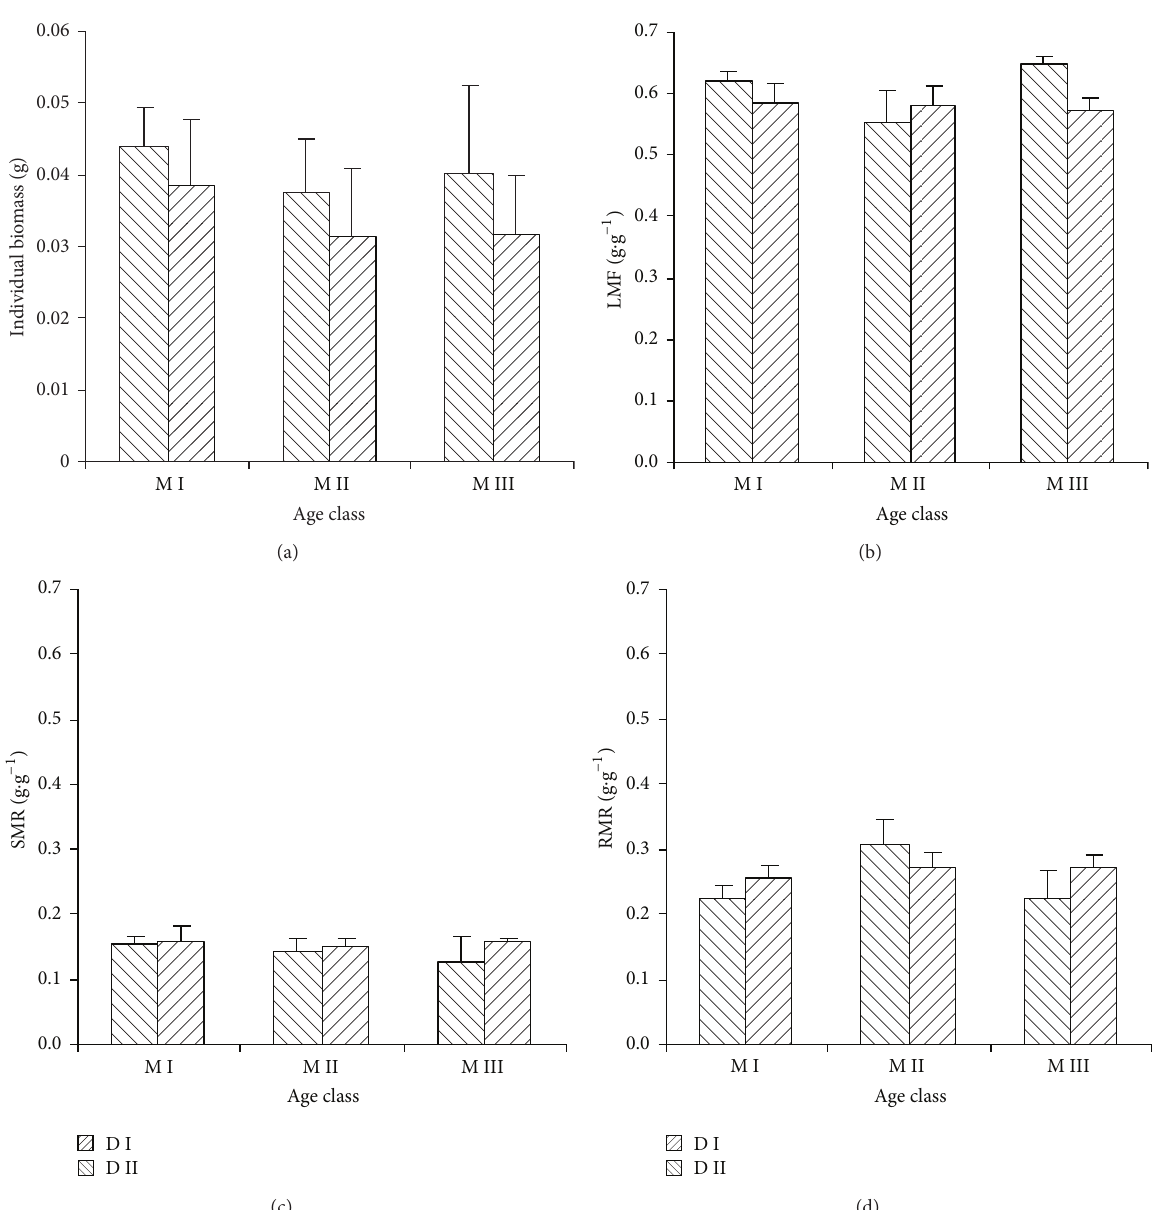
Figure 2: Effects of age and stand density of mother tree on seeding biomass